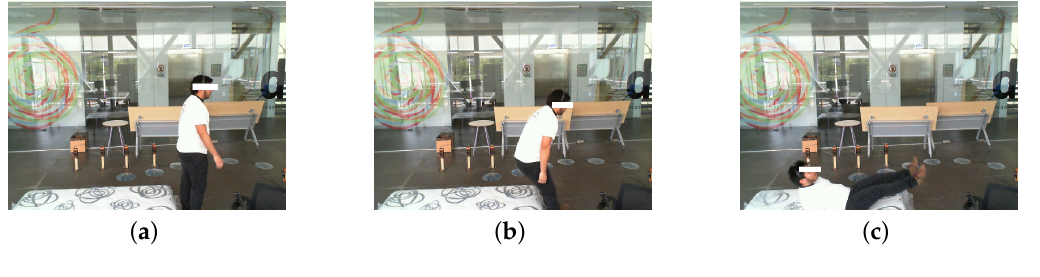
Figure 4. Examples of images inside a